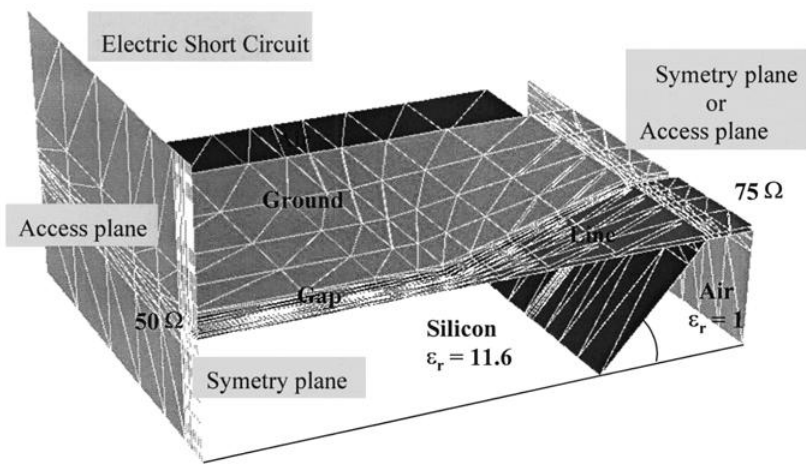
FIGURE 2 3D meshing of a quarter access of a micromachined coplanar